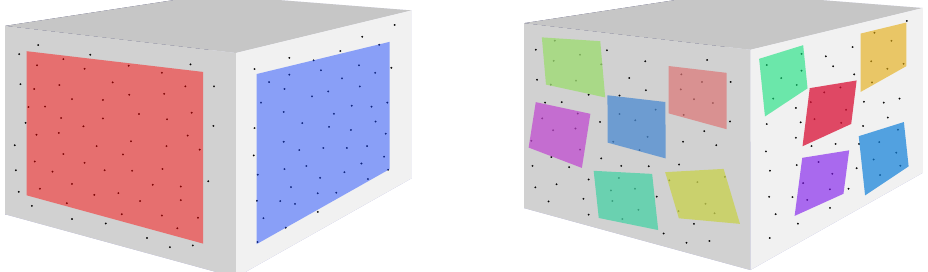
Figure 2. A conceptual comparison between the high-level planar feature in the PlaneLOAM system ( left ) and the cloud of planar points in the LOAM system ( right